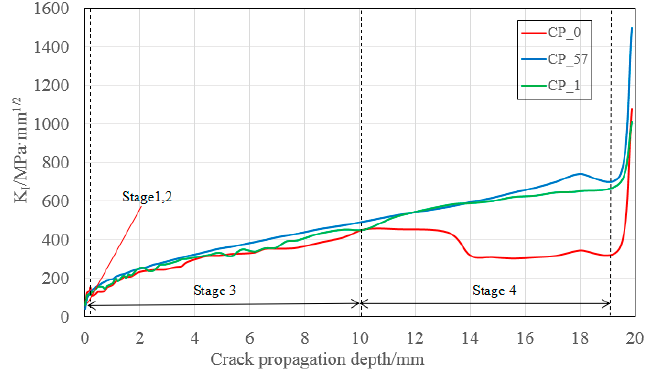
Figure 16. K I evolution of characteristic points ( K equ + SERR, first four stages).